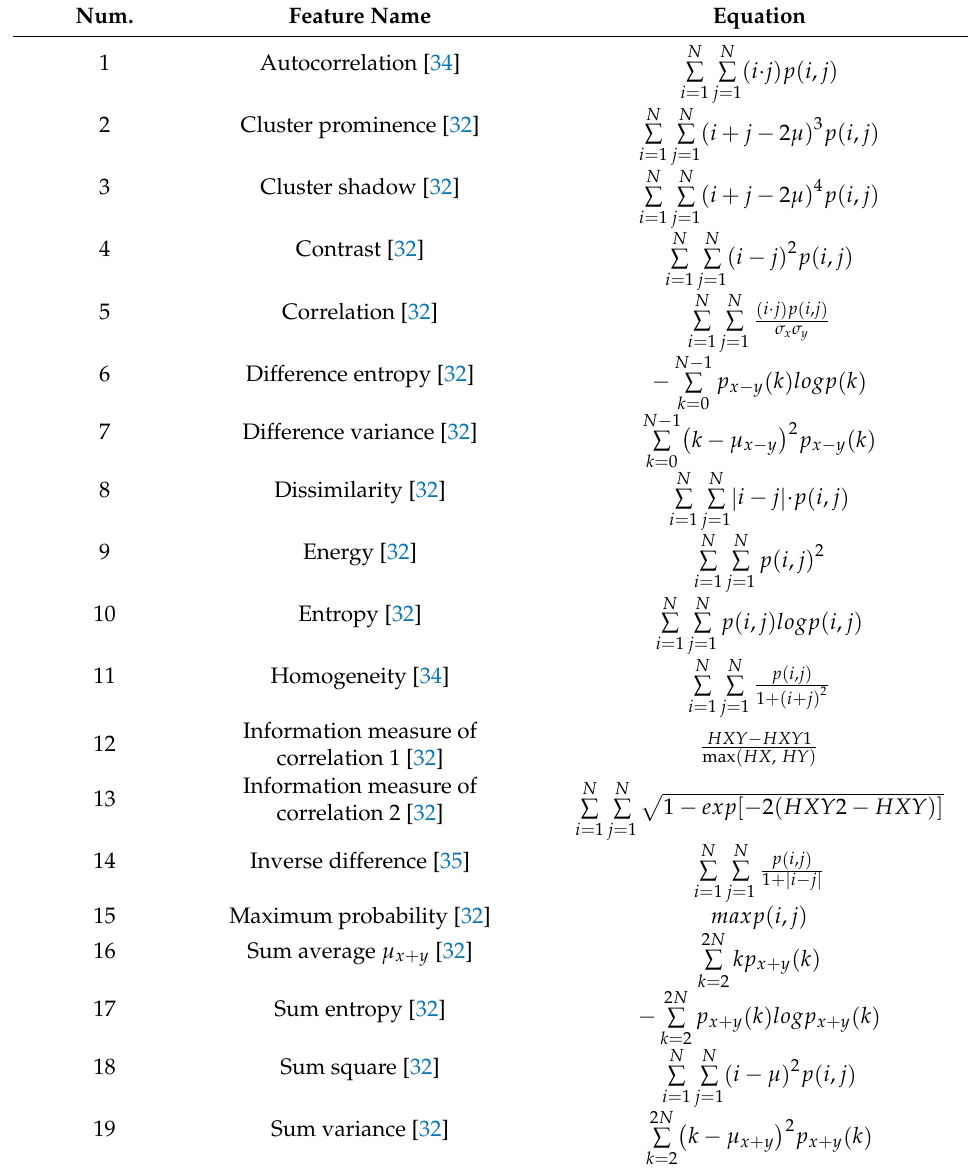
Table 3. Haralick texture features are used in this paper.